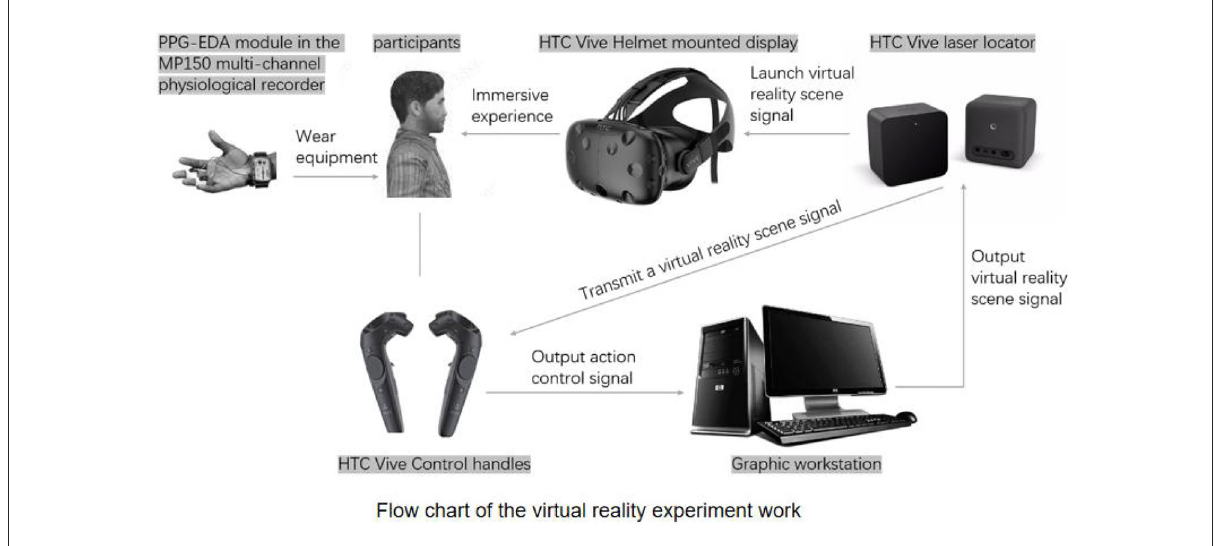
FIGURE4 Virtual reality experiment platform workflow.